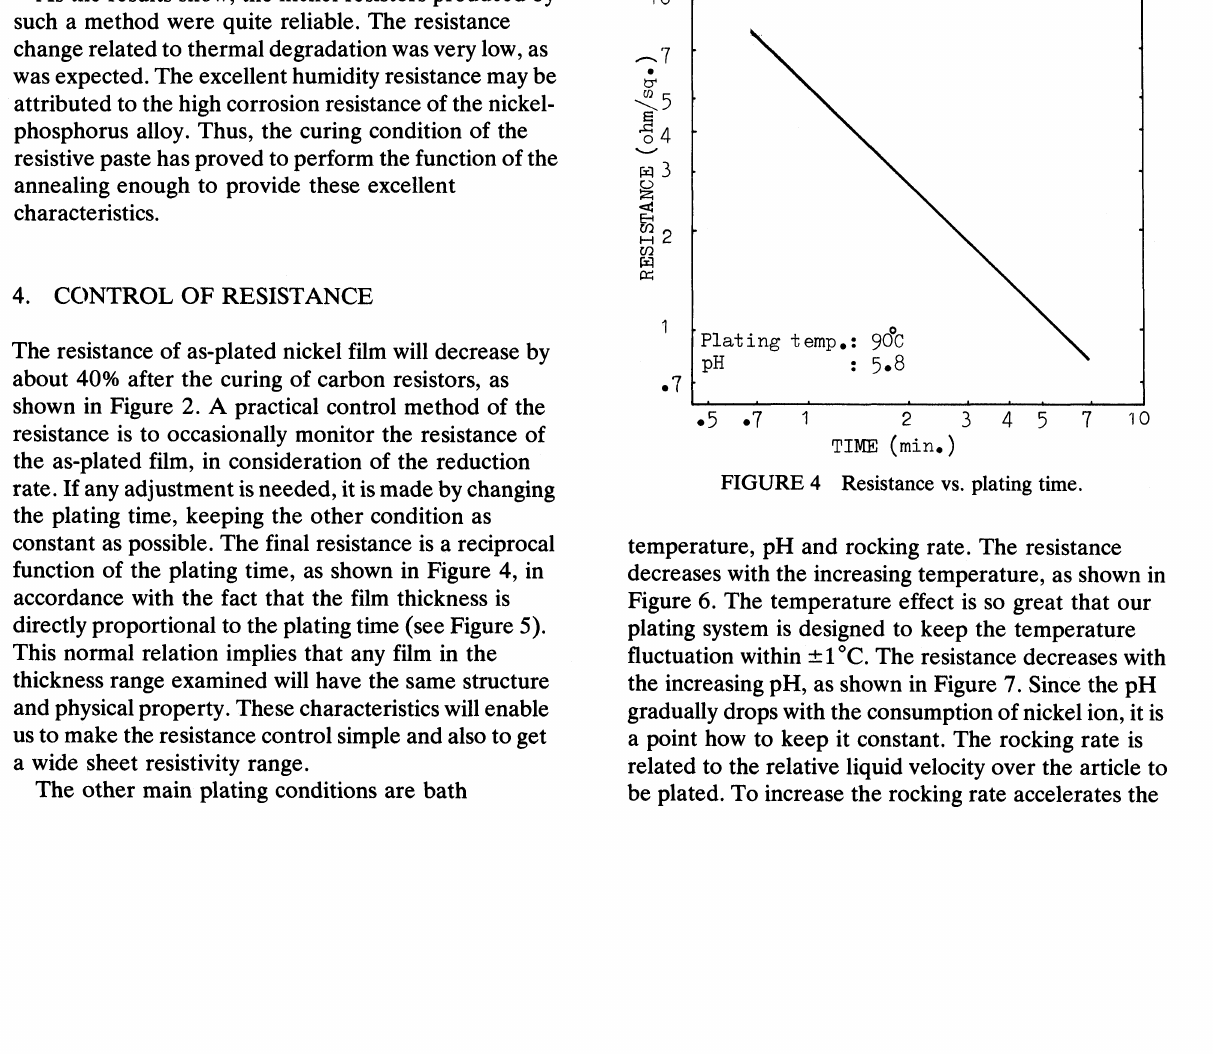
FIGURE 3 Life test results of Ni-P alloy resistors.